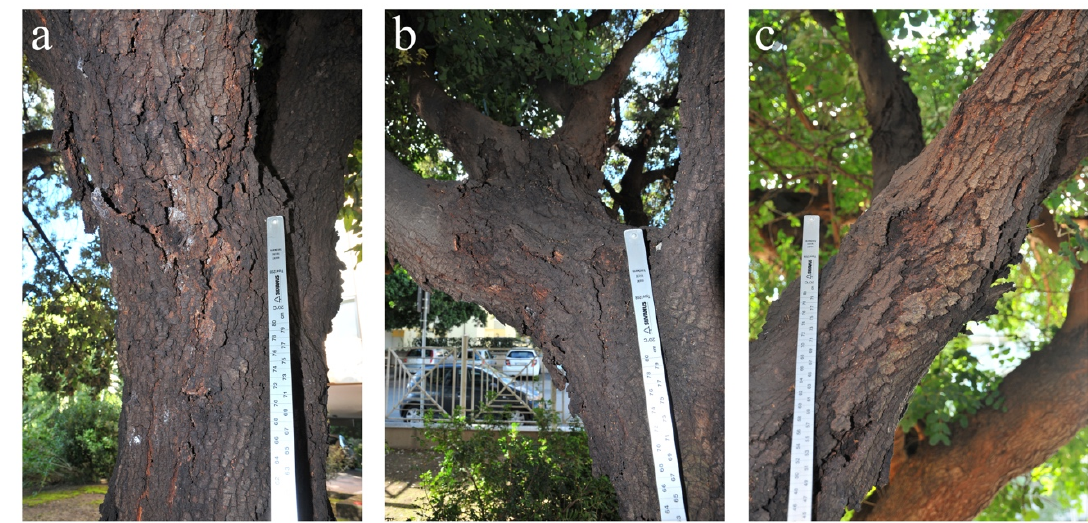
Figure 2. Bark darkening, splitting and detachment in the basal part of the different branches: ( a ) north side; ( b ) south side; ( c ) east side.